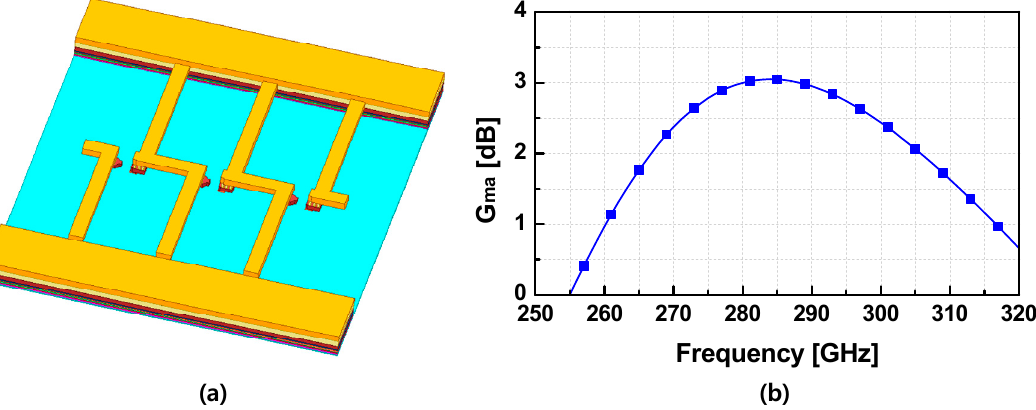
Figure 11. 3D HFSS model for EM simulation of three impedance matching stages ( a ), and G ma of three amplifying stages using EM simulated T-lines ( b